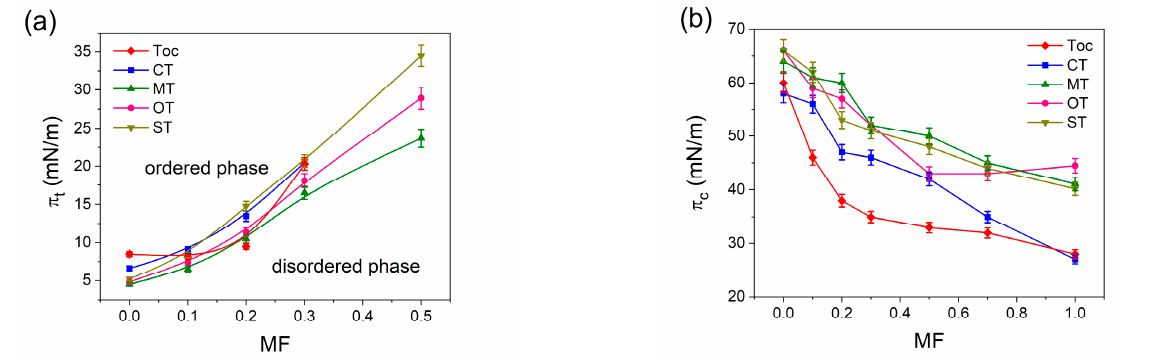
Figure 8. Plots of ( a ) LE/LC transition pressure π t and ( b ) collapse pressures π c for investigated tocopherols, as given in the legend. Error bars are SD calculated for three different repetitions.